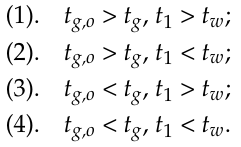
Figure 19. EGT as air temperature changed.